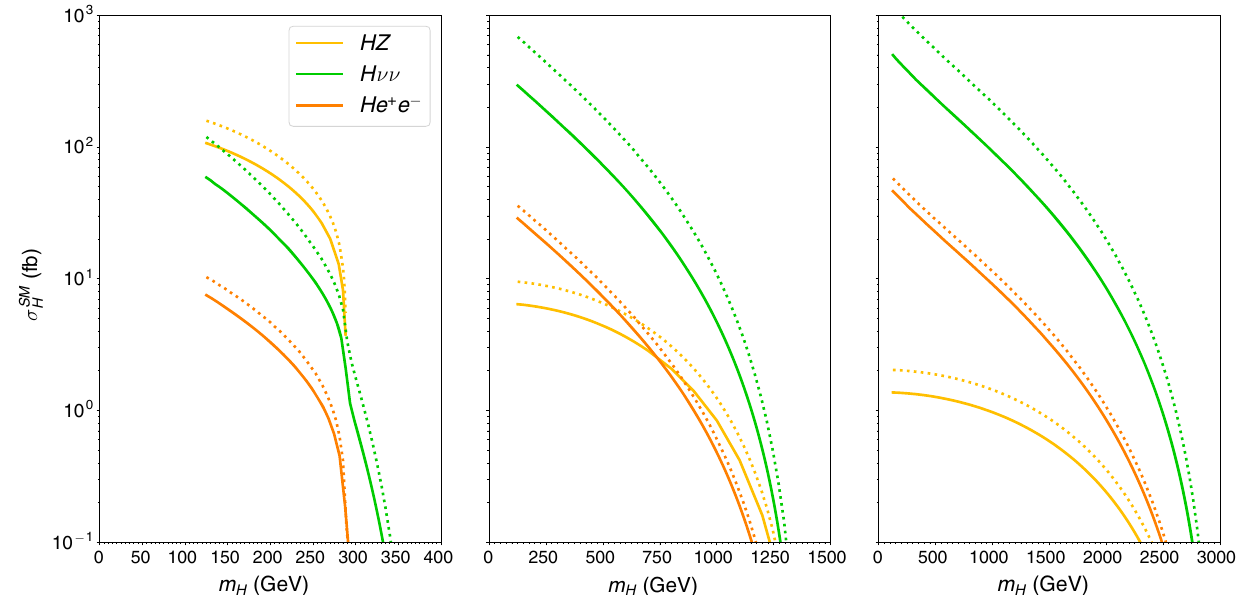
√ √ s = 380 GeV(left), s = 1400